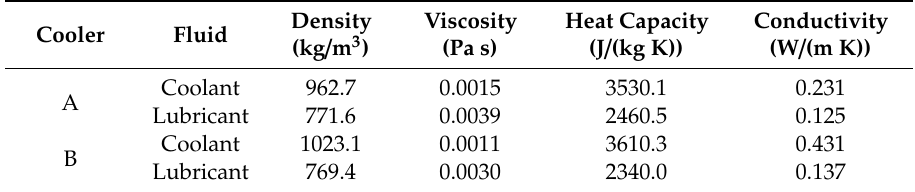
Figure 6. Overview of the two coolers considered in this work.